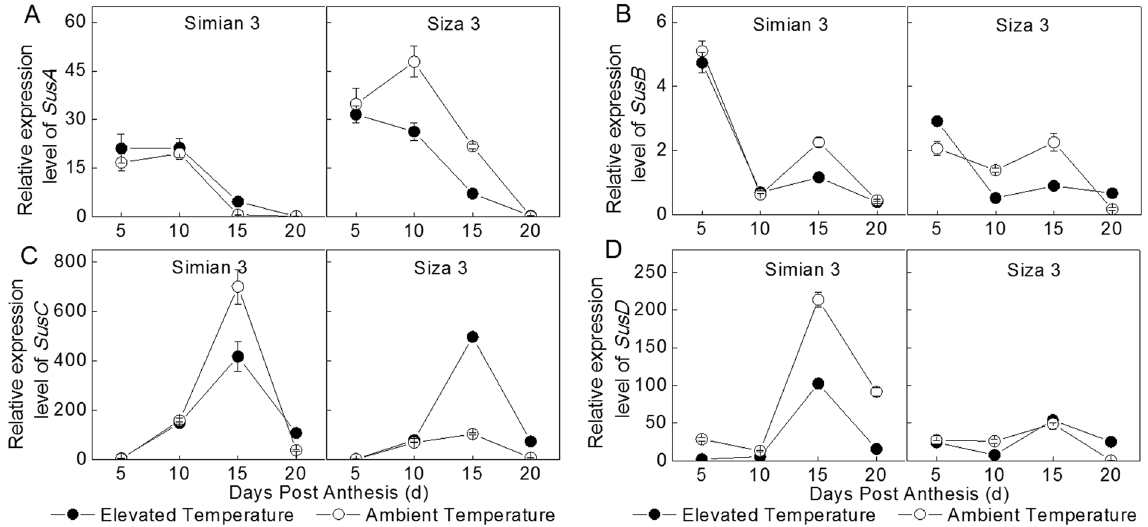
Figure 7. Relative expression quantities of key genes engaged in cotton fiber development in two temperature regimes, in 2012. SusA ( A ), SusB ( B ), SusC ( C ), SusD ( D ). Each data point represents the mean ± SE of three biological repeats.